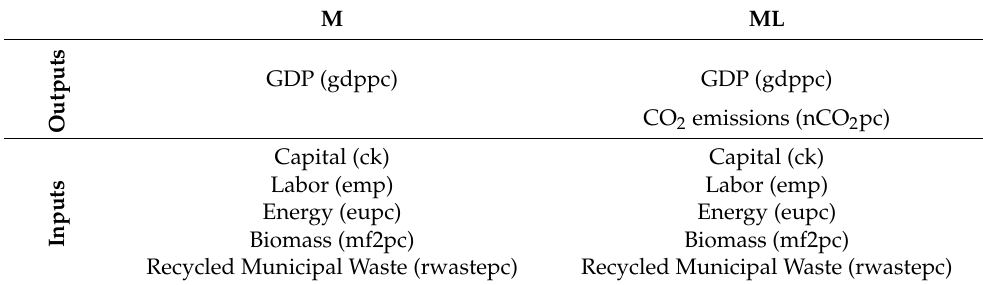
Table 2. Variables of DEA-based Malmquist and Malmquist–Luenberger productivity index models. M ML